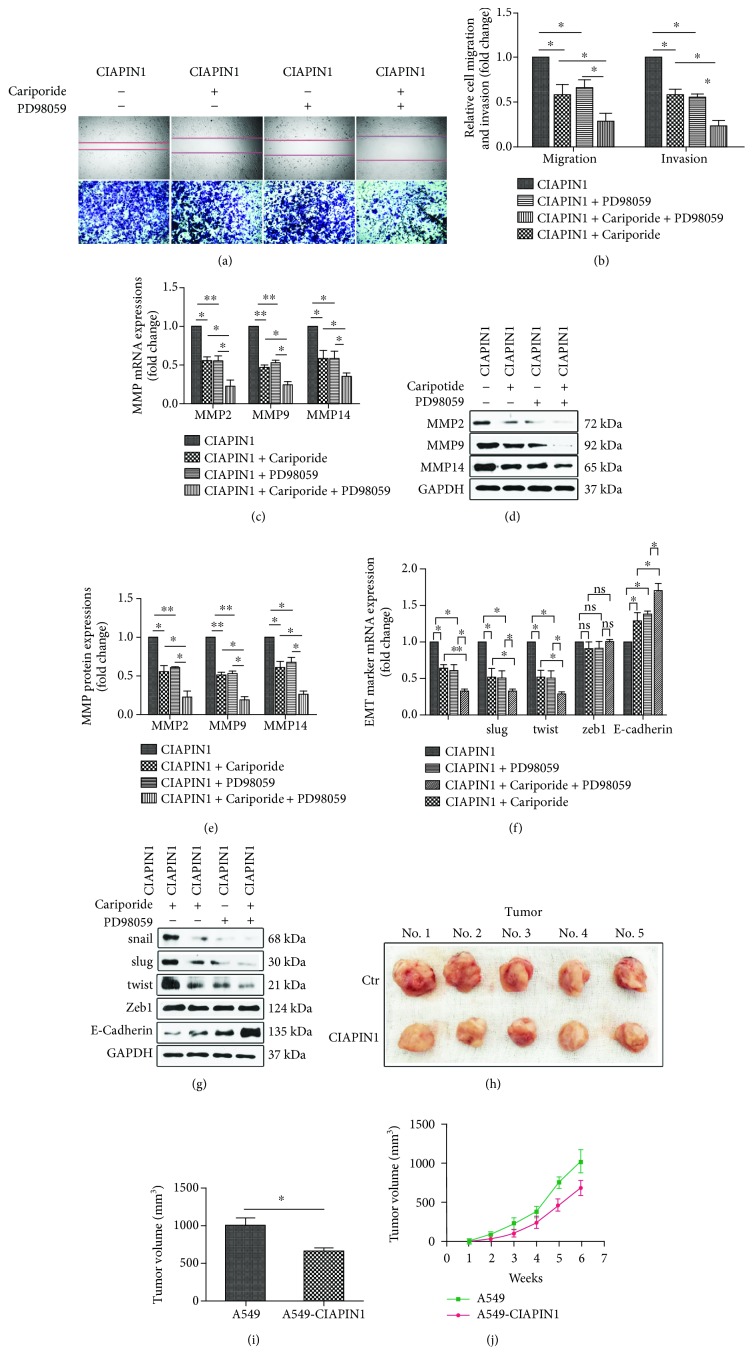
ERK1/2 signaling pathway was involved in A549 cells' metastasis conferred by CIAPIN1. (a) A549 cells with CIAPIN1 overexpression were treated with Cariporide or PD98059, and then cells' migration and invasion were measured by wound healing and Transwell assays. (b) Changes of A549 cells' migration and invasion after indicated treatments were detected. (c–e) Cariporide or PD98059 was added to A549 cells with CIAPIN1 overexpression, and the expressions of MMP2, MMP9, and MMP14 were detected. The quantification of MMPs was shown. (f, g) Cariporide or PD98059 was added to A549 cells with CIAPIN1 overexpression, and the expressions of snail, slug, twist, zeb1, and E-cadherin were detected. (h, i) CIAPIN1 upregulation led to the suppression of tumor volume. Tumor volume was calculated for a period of 6 weeks. (j) CIAPIN1 upregulation led to decreased tumor outgrowth analyzed by the tumor growth curve. Each value indicated the mean ± SD of three independent experiments. ∗P < 0.05, ∗∗P < 0.01, compared with control.